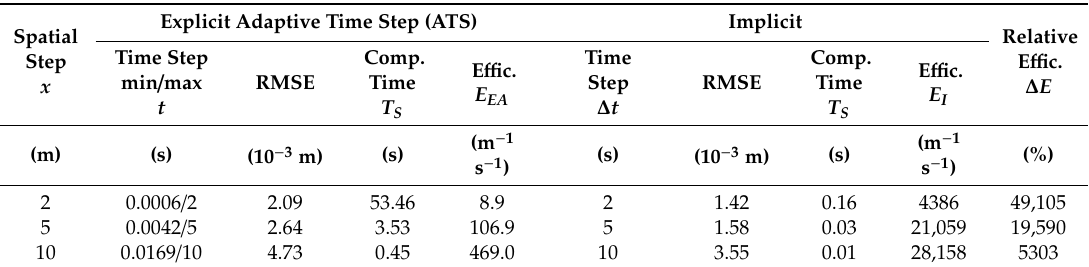
Table 3. Accuracy and e ffi ciency statistics (the total computation time, the computational e ffi ciency, and (Equation (32)) the relative e ffi ciency (Equation (34b)) for the explicit scheme with the constant time step, the adaptive time step (ATS), and the implicit method with θ = 0.5 and ω =